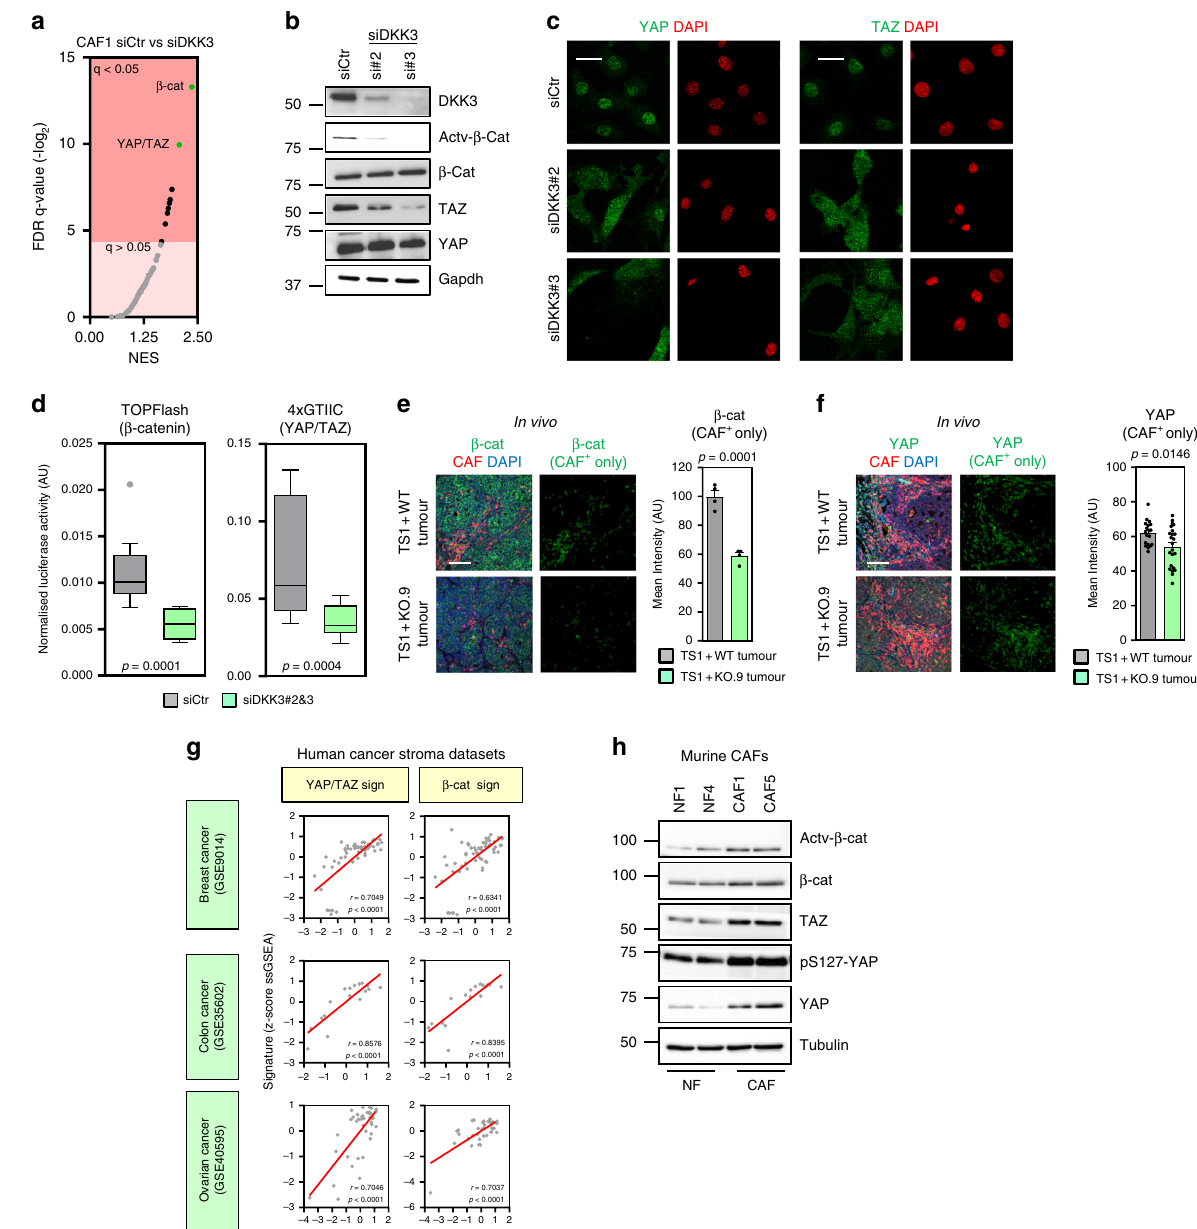
Fig. 5 DKK3 potentiates β -catenin and YAP/TAZ signalling in CAFs. a Graph showing GSEA of murine CAF1 after transfection with control siRNA (CAF- siCtr) vs CAF1 after transfection with DKK3 siRNAs (si#2 and si#3). The graph indicates the Normalised Enrichment Score (NES) and False Discovery Rate (FDR) q -value (-log 2 ) for each gene set. In green, top differential gene-sets, including β -catenin and YAP/TAZ. b Western blot showing DKK3, non- phospho (active) β -catenin (Ser33/37/Thr41), β -catenin, TAZ,YAP and Gapdh levels in CAF1 after transfection with control (siCtr) and two independent DKK3 siRNA. c Images show YAP (left panels) or TAZ (right panels) localisation (green) and DAPI staining (red) in CAF1 after transfection with control (siCtr) and two independent DKK3 siRNA. Scale bars, 20 µ m. d Tukey boxplots show luciferase activity (Fire fl y/Renilla) indicative of β -catenin activation (TOPFlash reporter) or YAP/TAZ activation (4xGTIIC-lux reporter) in CAF1 after transfection with control (siCtr) or DKK3 (si#2&3) siRNAs; n = 9 for β - catenin, n = 17 for YAP/TAZ. e Left panels show total β -catenin (green), S100A4 (CAF marker, red) and DAPI (blue) staining of TS1 tumours admixed with WT or KO.9-CAFs. Right panels show processed images showing β -catenin staining in CAF-positive areas. Scale bar, 100 µ m. Chart shows mean β -catenin intensity in CAFs. Bars represent mean ± SEM ( n = 4 fi elds of view). f Left panels show total YAP (green), S100A4 (CAF marker, red) and DAPI (blue) staining of TS1 tumours admixed with WT or KO.9-CAFs. Right panels show processed images showing YAP staining in CAFs. Scale bar, 100 µ m. Chart shows mean YAP intensity in CAFs. Bars represent mean ± SEM ( n = 19 or more fi elds of view). g Graphs show correlations between DKK3 gene expression and the expression of CAF-speci fi c YAP/TAZ and β -catenin signatures (z-score normalised) in normal and cancerous stroma from mammary gland, colorectal and ovarian human tissues. Pearson correlation coef fi cient ( r ) and p values are shown. h Representative Western blot showing non- phospho (active) β -catenin (Ser33/37/Thr41), β -catenin, TAZ, phospho-S127-YAP, YAP and tubulin in murine NF1, N4, CAF1 and CAF5. For all graphs, * P < 0.05; ** P < 0.01; *** P < 0.001; # P < 0.0001; n.s., non-signi fi